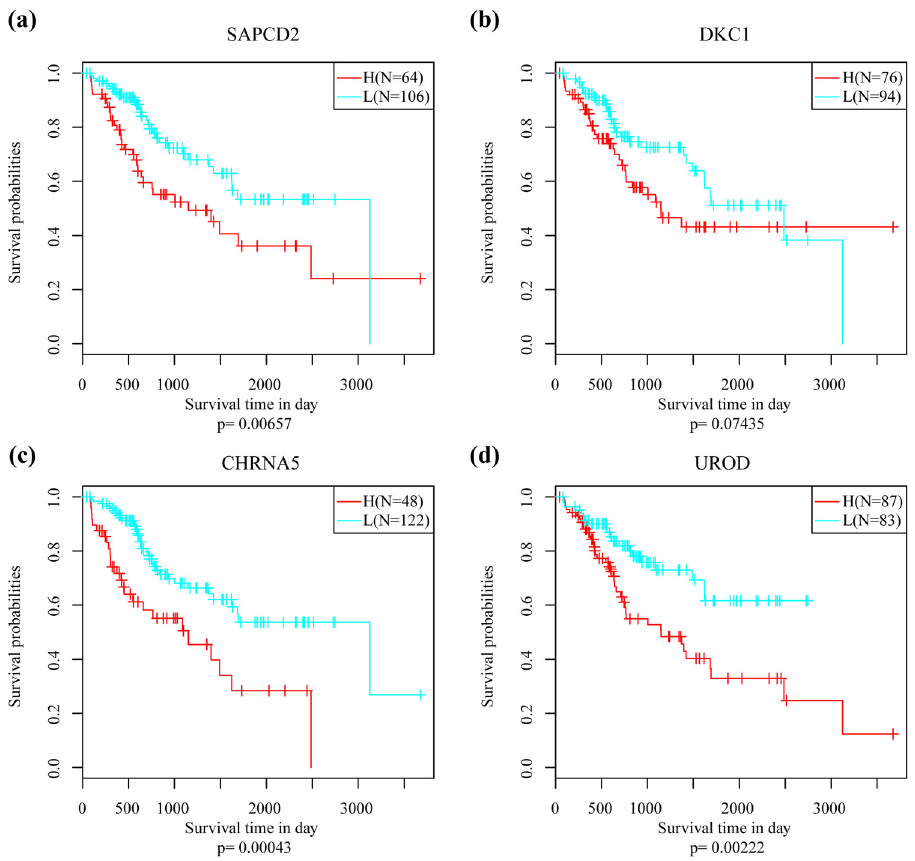
Figure S1: KM OS curve of ( a ) SAPCD2, ( b ) DKC1, ( c ) CHRNA5 and ( d ) UROD in high and low risk